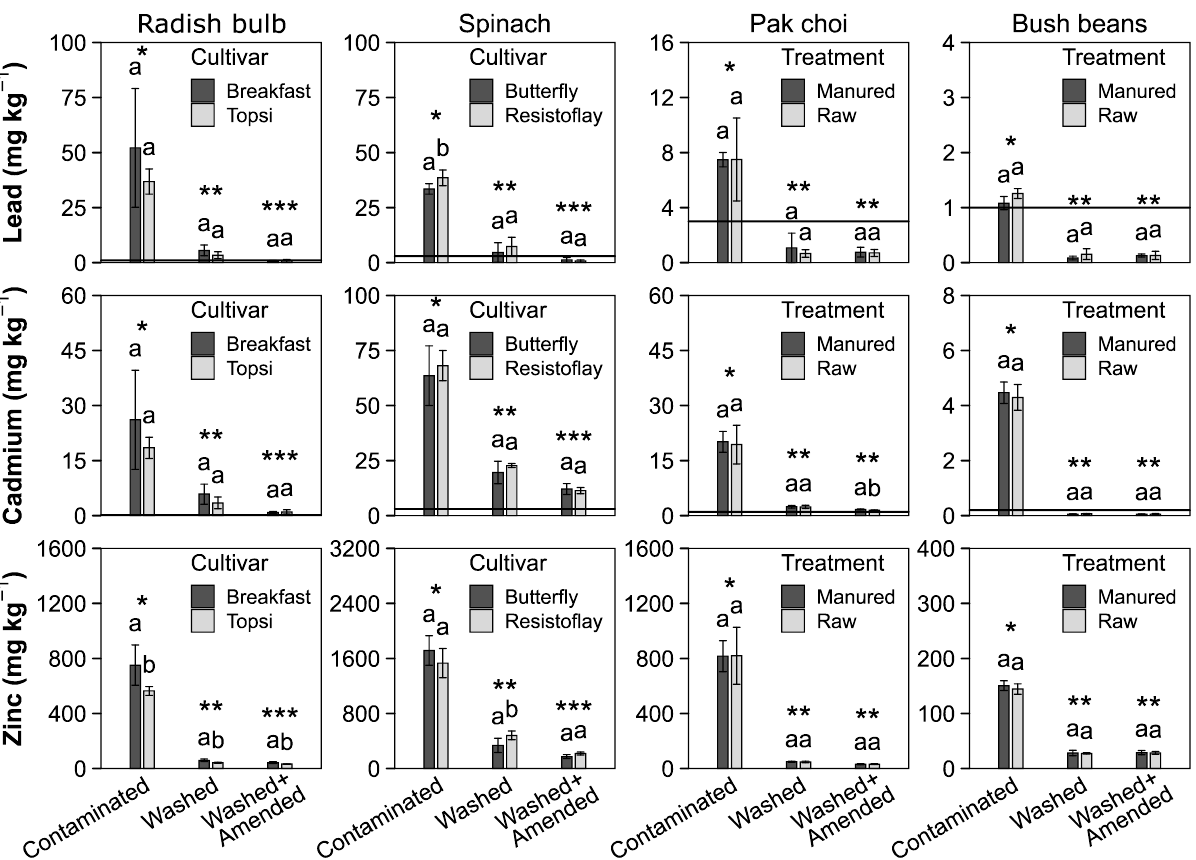
Figure 3. Uptake of heavy metals into eatable parts of different vegetables (mean ± SD, n = 4). The dashed line indicates EU guide values adapted for dry weight, assuming 90% water content. Different numbers of asterisks represent significant differences among soil treatments (Welch test, p < 0.05). Different lower-case letters indicate significant differences between cultivars and the green manuring in the same soil treatment (Dunn test, p < 0.05). Different number of asterisks indicates a significant difference between die soil treatments (Dunn test, p < 0.05).